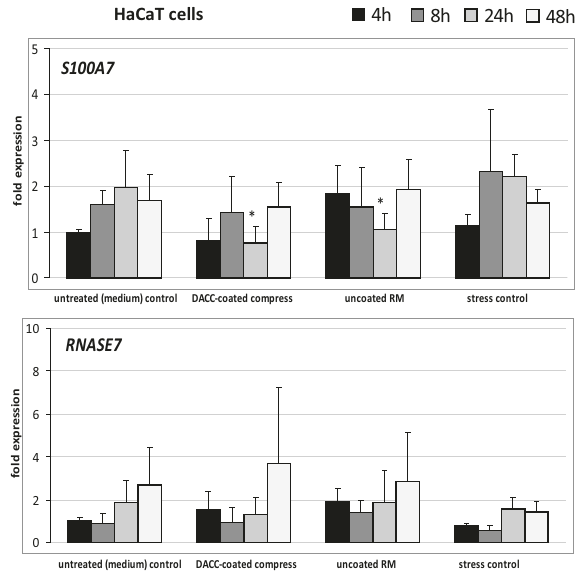
Fig. 7 Gene expression of antimicrobial peptides under treatment with DACC and untreated RM during HaCaT scratch wound healing compared to the untreated (medium) control and the stress control. Quantitative analyses of gene expression for the antimicrobial peptide genes S100A7 and RNASE7 were performed at 4, 8, 24, and 48 hours (h). Relative gene expression was normalized to the housekeeping gene ACTB . Data are presented as — fold gene expression compared to the untreated (medium) control at the start of the experiment. Asterisks indicate a signi fi cant deviation at the respective time point from the untreated control (* p < 0.05; ** p < 0.01; *** p < 0.001)